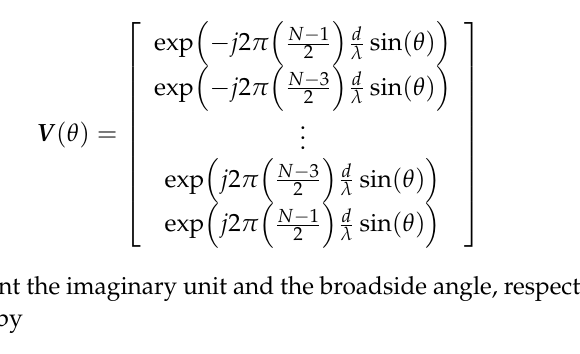
where S d and Y represent the directed signal before DBF synthesis and the signal after DBF synthesis, respectively; and X and S n represent the vector of observed multichannel received signal and the vector of thermal noise, respectively. X ∈ C N × 1 , and S n ∈ C N × 1 . Term w H denotes the vector of DBF weights generated in real-time. w H ∈ C 1 × N . Term V refers to the array manifold vector. V ∈ C N × 1